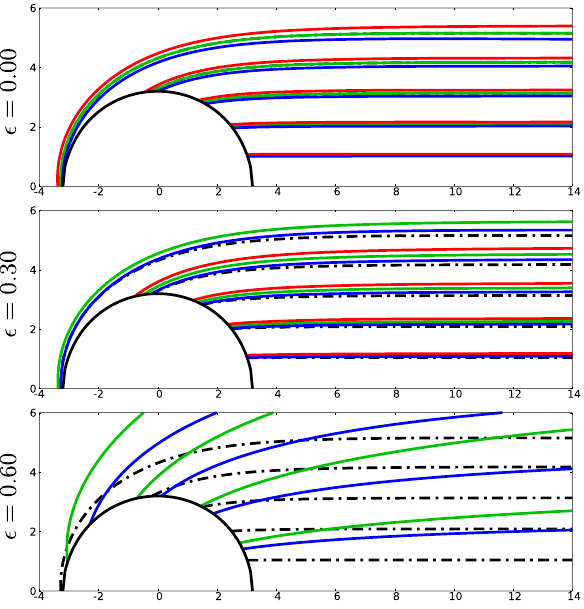
Fig. 3 Same as in Fig.2 but for h = 0. As the ratio (cid:11) = ω e ( R )/ω( R ) increases, both the apparent size of the star b max and the maximum visibility angle θ max diverge. Note there is not plot at (cid:11) = 0 . 9, because it does not satisfy the propagation condition (3.24). In addition, for q ∗ < 0, as the value of (cid:11) increases so does the radius of the photon sphere, eventually exceeding the stellar radius, so that trajectories with b ≤ b max do not reach the observer. That is why we do not show the q ∗ < 0 example in the bottom